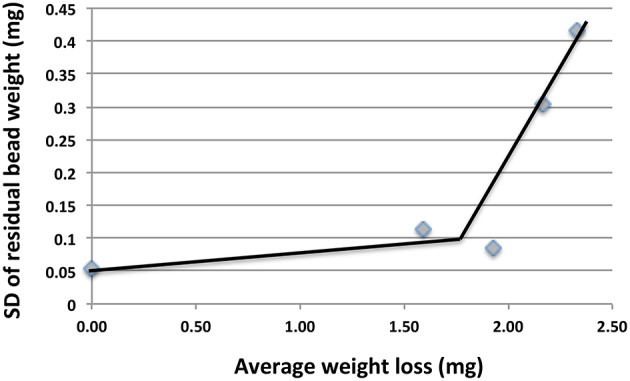
Plot of standard deviation (SD) of residual bead weights vs. average weight loss for incubations in Table 2. The increase in SD with increased weight loss indicates unevenness of the corrosion.